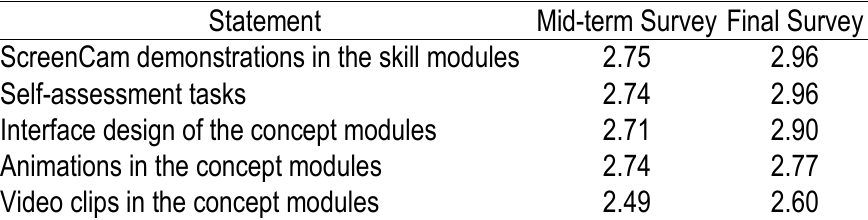
Table 3. Perceived usefulness of various components on a 4-point Likert scale